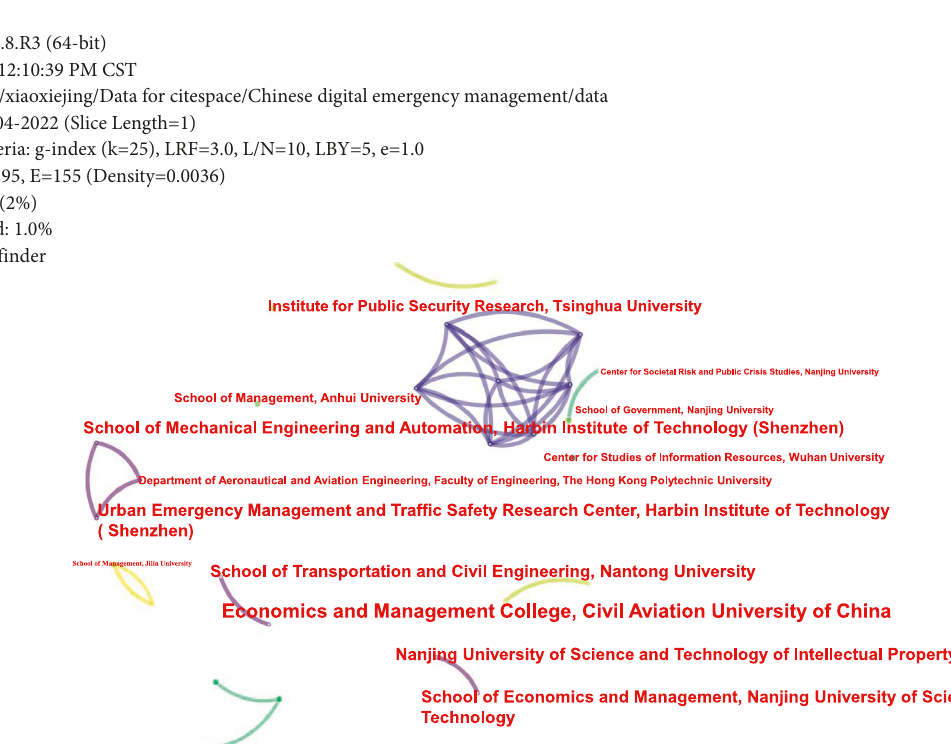
Figure 5: Institutions’ cooperation network of Chinese DEM research.